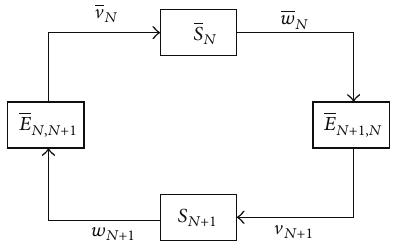
In Figure 1, 𝐸 𝑁,𝑁+1 = [𝐸 T 1,𝑁+1 , 𝐸 T 2,𝑁+1 , . . . , 𝐸 T 𝑁,𝑁+1 ] T